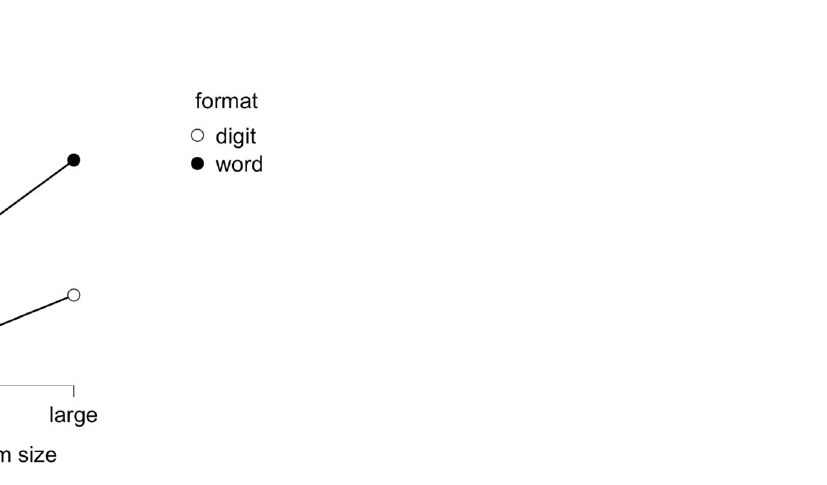
Figure 11. JASP screenshot of the Descriptive Plots output, showing the condition means formed by crossing the two factors of problem size and